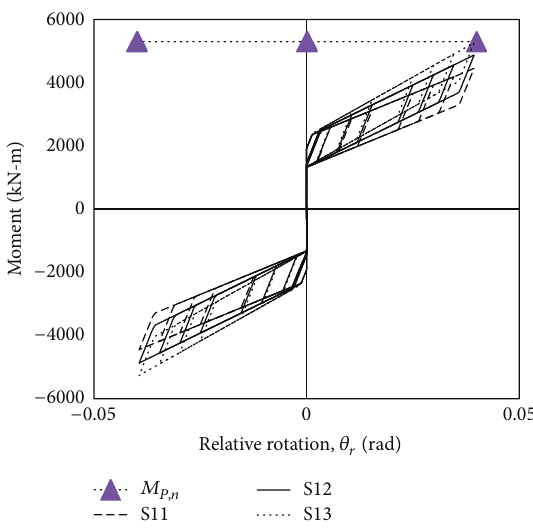
Figure 13: Moment-relative rotation response S11, S12, and S13.